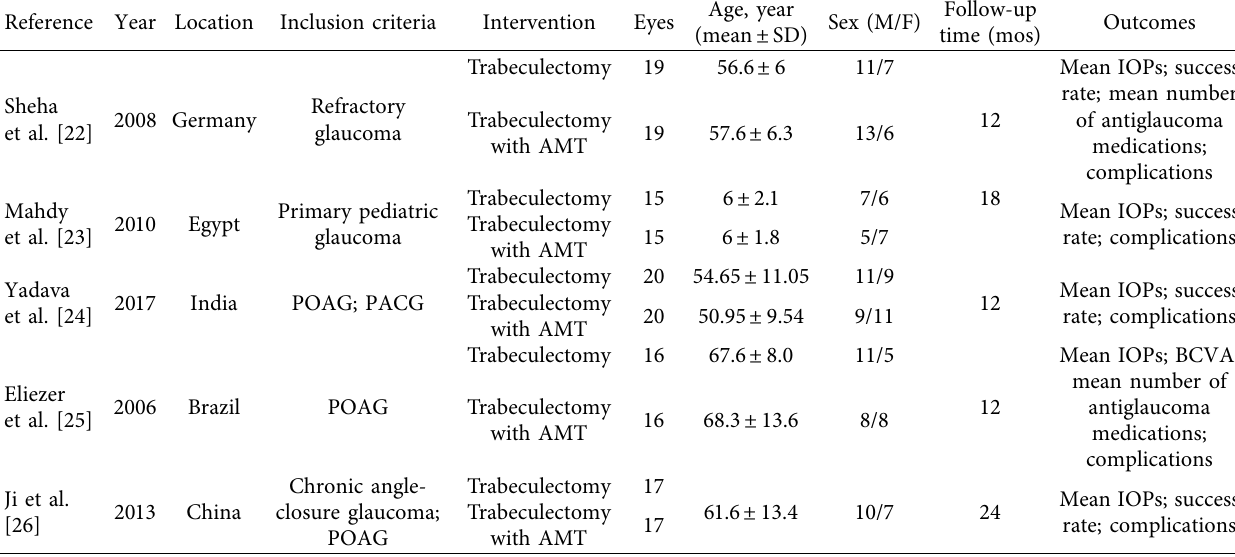
Table 1: Patient characteristics in the included trials.